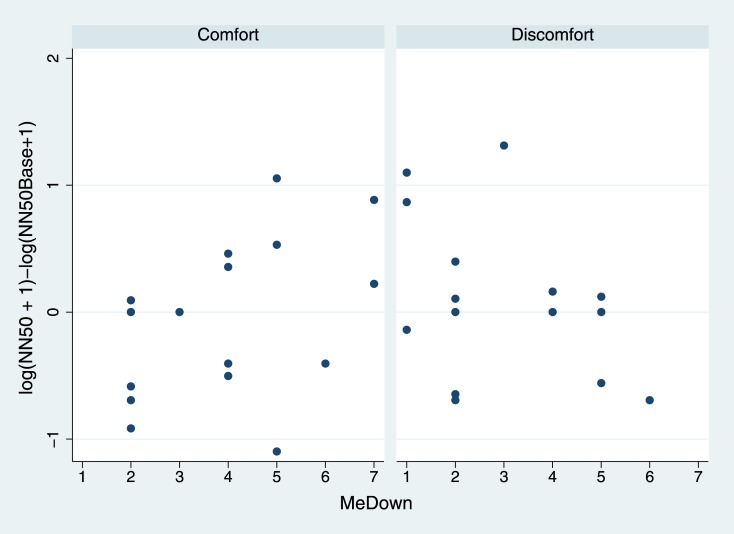
Change in NN50 (Heart Rate Variability) by MeDown and Condition.Note that the NN50 scores have been incremented by 1 for this graph in order to avoid log(0).